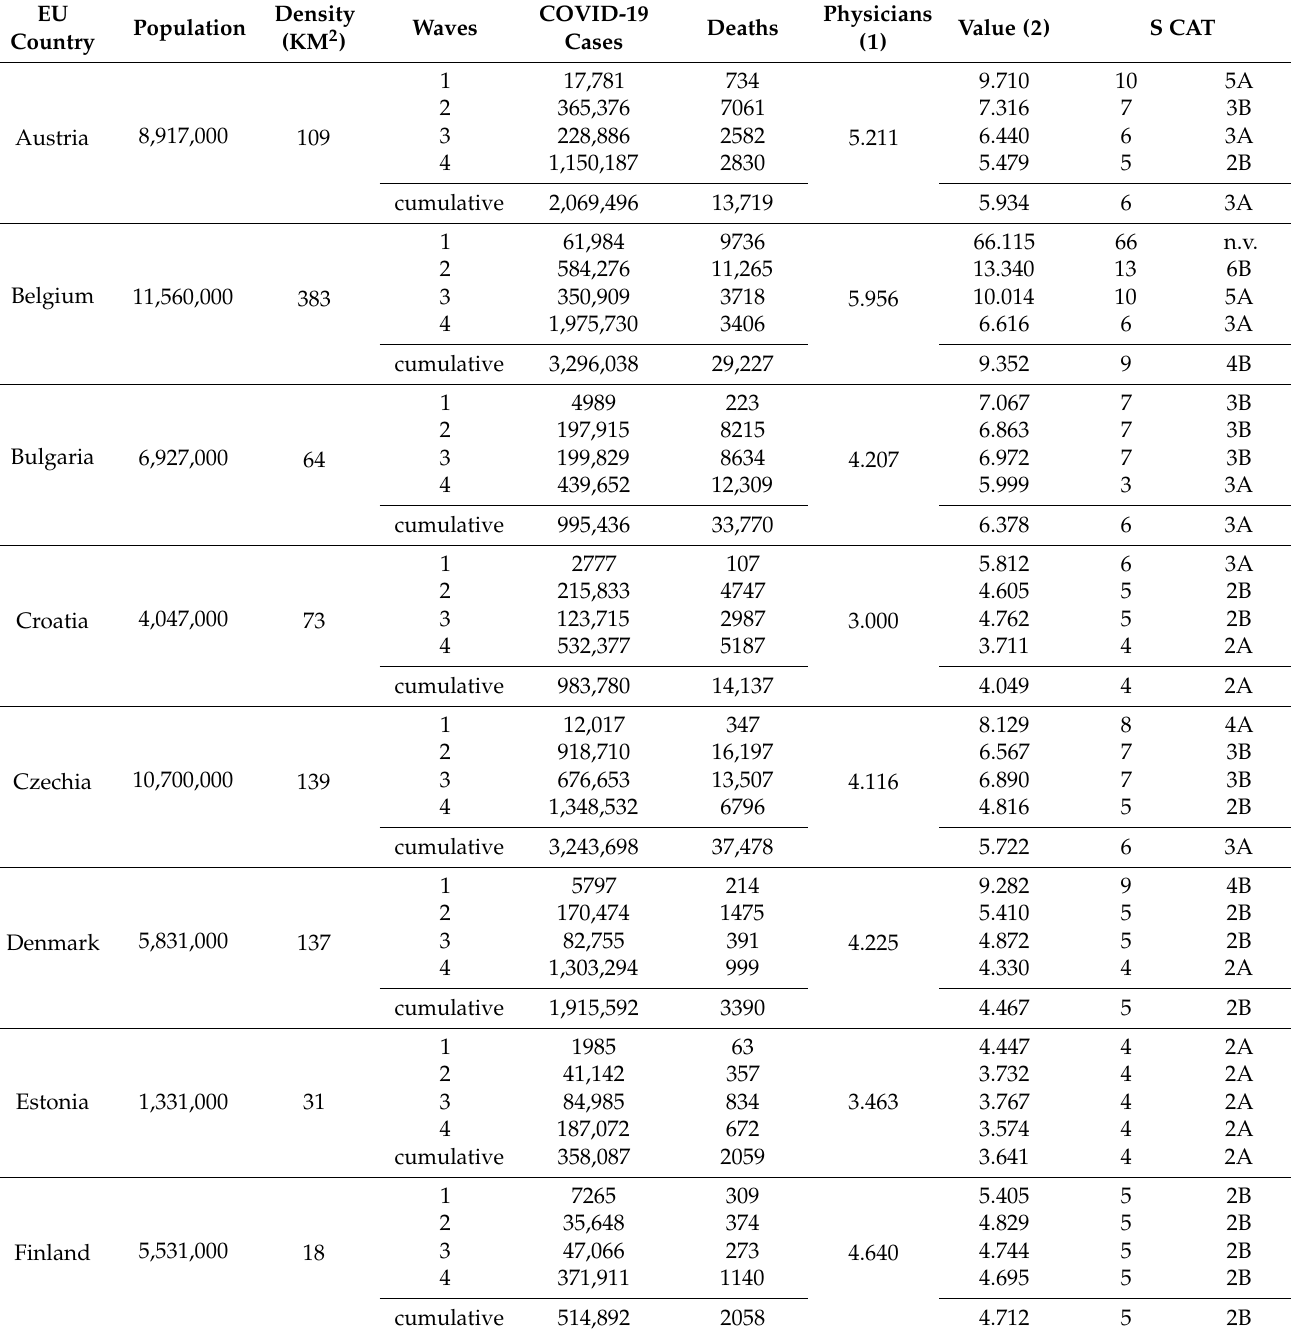
Statistics OECD for country data and from the European Centre for Disease Prevention and Control, 2022). This evaluation, despite being largely approximated, provides a certain weight to each management policy implemented to address the COVID-19 pandemic in different European countries. Table 1. Overview of the COVID-19 epidemiological and demographic landscape in the main European countries during each COVID-19